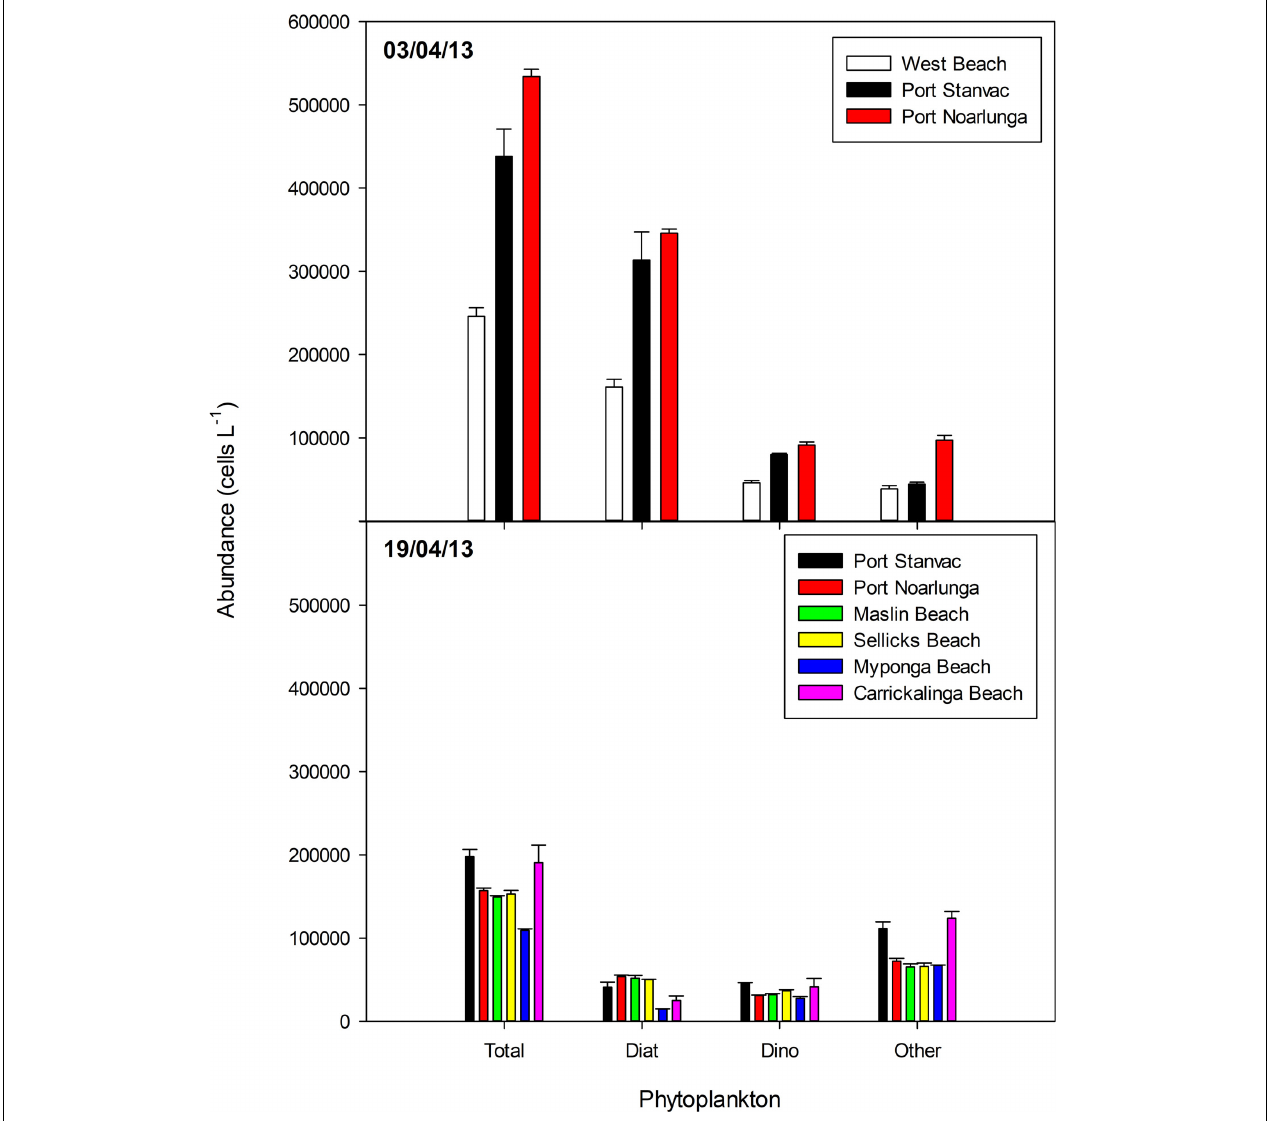
FIGURE 6 | Variation in mean phytoplankton abundance in samples collected in Gulf St Vincent on 3 and 19 April 2013. Error bars indicate standard error. Station locations are displayed in Table 2